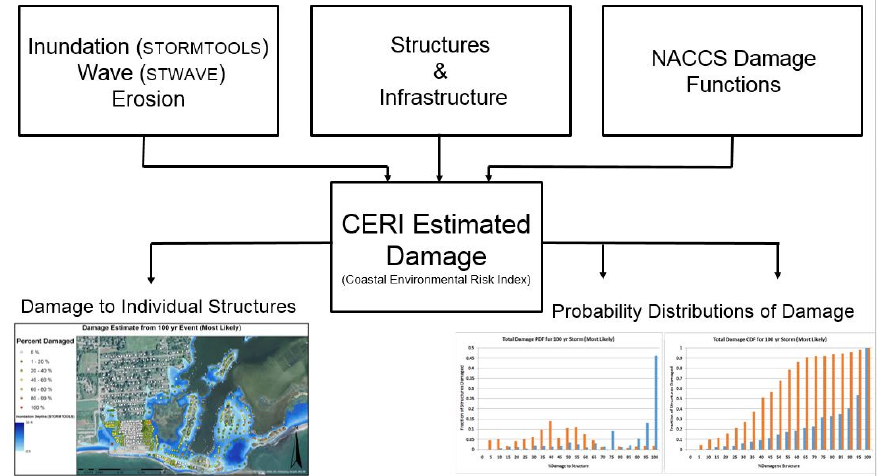
Figure 5. Flow chart showing the methodology used to estimate damage from storm surge and sea level rise in this study (See [3]). CERI, Coastal Environmental Risk Index; NACCS, North Atlantic Coast Comprehensive Study.